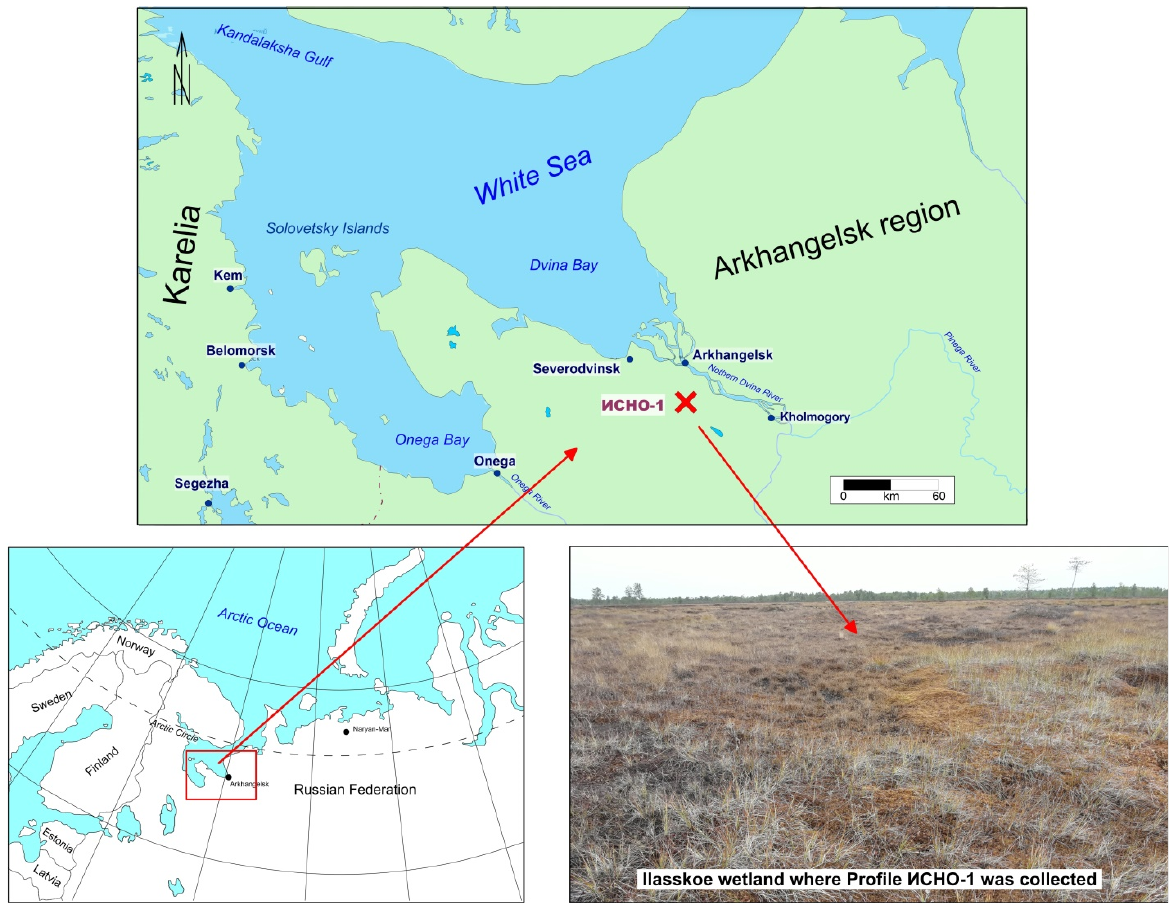
Figure 1. Location of the studied Ilasskoe peatland where the peat profile ISNO-1 was collected (Arkhangelsk Region). The red cross, arrow and rectangle in the figure indicate the sampling location.